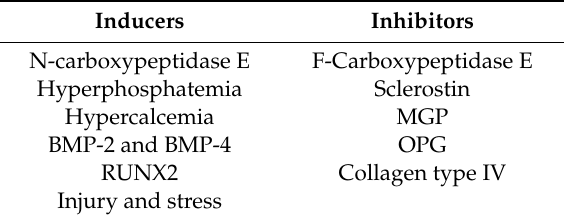
Table 1. Vascular calcification regulatory agents, including known inducers and inhibitors.